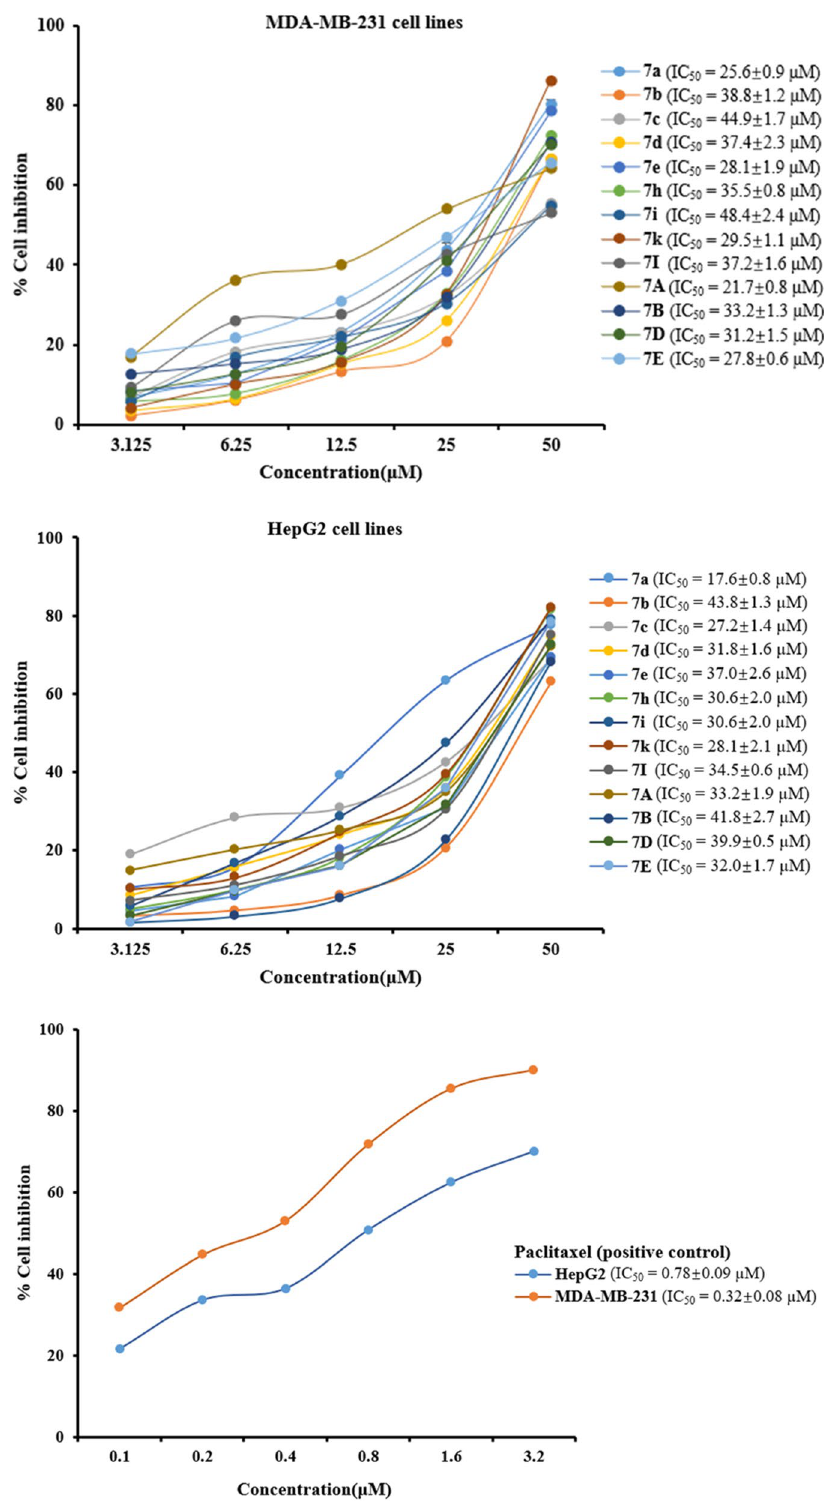
Figure 5. Dose–response analysis of cell growth inhibition activity against MDA-MB-231 and